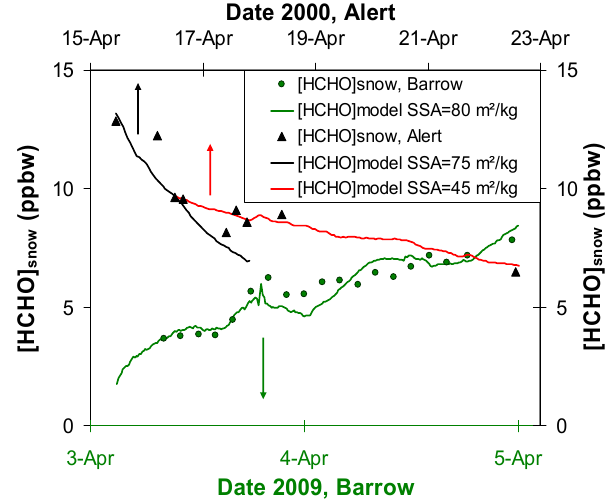
Fig. 3. Interpretation of changes in the HCHO concentration, [HCHO] snow in surface snow at Alert in 2000 and at Barrow in 2009, by solid state diffusion of HCHO in and out of snow crystals, after Barret et al (2011a, b). Based on time series of P HCHO , on the specific surface area (SSA) of the snow, Barret et al. modeled [HCHO] and found a good agreement between modeled and measured values. SSA was kept constant in the Barrow case, as variations were small over 2 days. For the Alert case, 2 values were used to account for changes over 7 days, as the model does not allow SSA continuous variations.